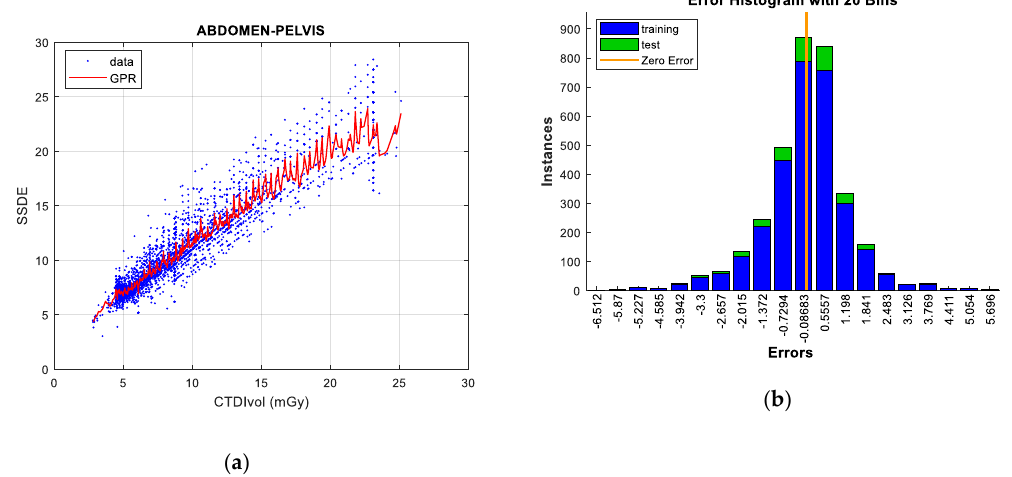
Figure 12. SSDE prediction according to CTDIvol for Abdomen & Pelvis protocol ( left ), together with error histograms ( right ), employing the GPR technique ( a , b ). Table 17. SSDE-CTDI VOL results for Thorax